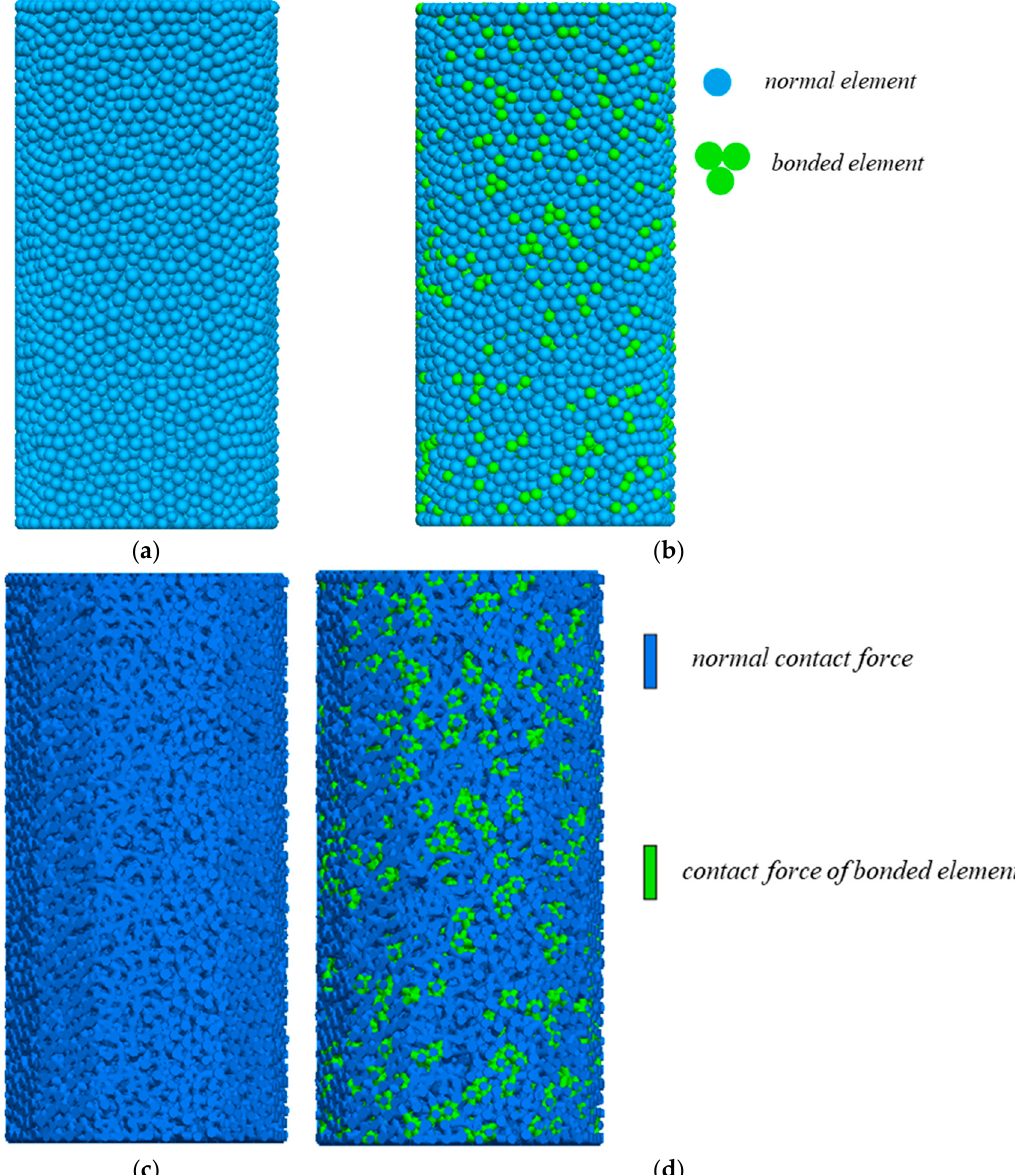
Figure 14. Model and contact states of undisturbed and remolded soil. ( a ) Main body of remolded soil. ( b ) Bonded clusters and the main body of undisturbed soil. ( c ) Contact state of remolded soil. ( d ) Contact state of undisturbed soil.